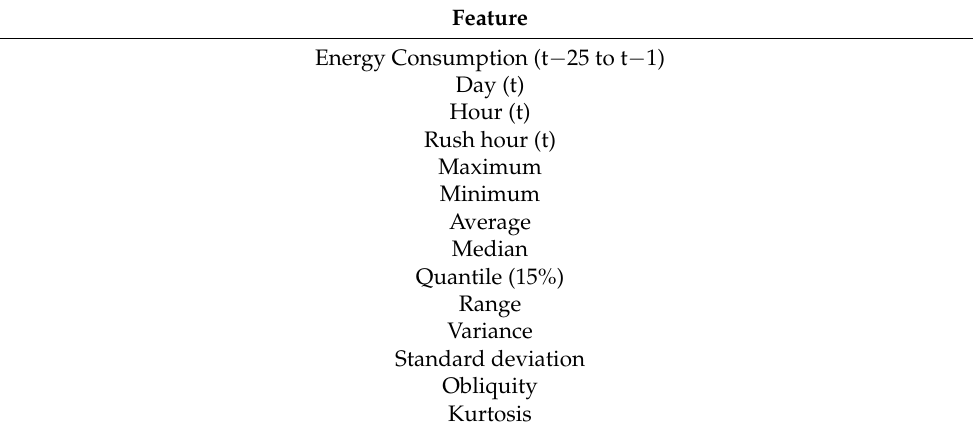
Table 6. Set of evaluated